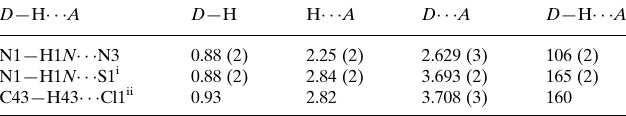
Hydrogen-bond geometry (A˚ , (cid:2)